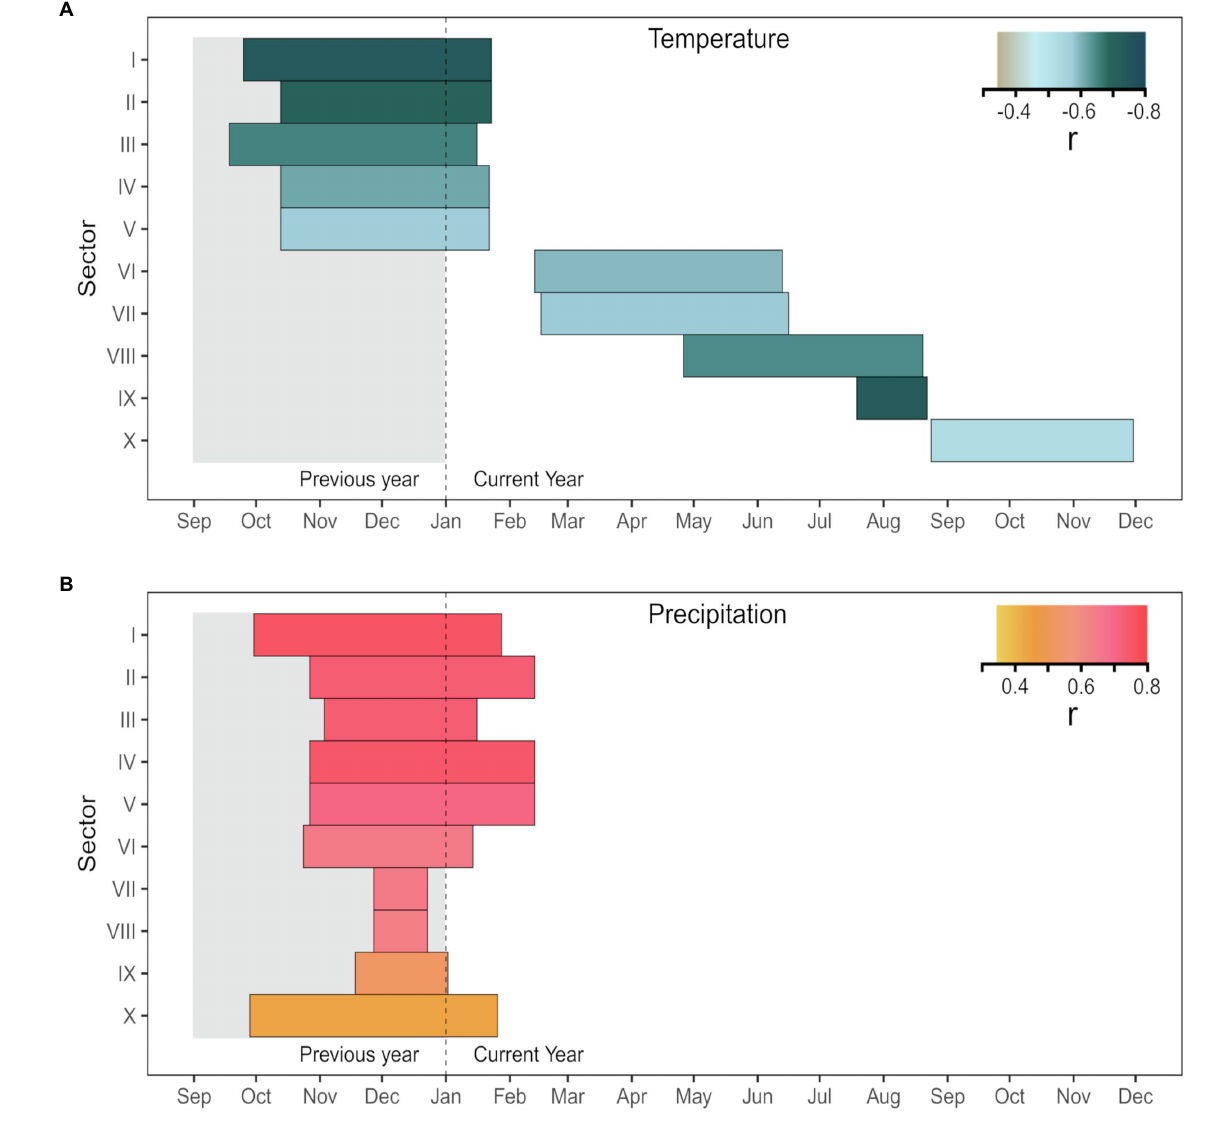
FIGURE 5 | Correlations of sector chronologies of lumen diameter with daily (A) maximum temperature (Tmax) and (B) precipitation for the period 1981 to 2015. The horizontal length of each bar corresponds to the strongest optimal period identified by the moving window correlation analysis. All correlations, whose value is given by the color, are significant at p <